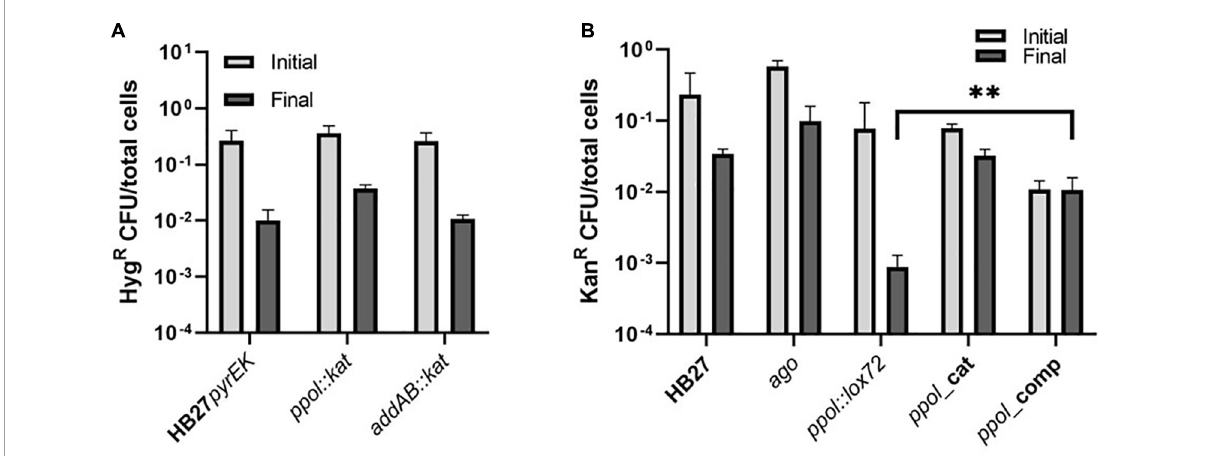
FIGURE5 Plasmid stability in the Thermus. thermophilus mutants. (A) Comparison of plasmid loss frequencies using a replicative plasmid conferring Hyg resistance (pMotH1103A) in HB27 pyrEK control strain and in ppol:kat and addAB:kat insertion mutant strains. Transformed cells were re-streaked twice on selective plates and grown on selective media liquid for 24 h. After that, cells were further incubated for another 48 h in the absence of antibiotic to allow plasmid loss to occur. We finally plated cells on both non-selective and selective plates and the plasmid loss frequency was measured as the CFUs on selective media divided by CFUs on non-selective plates (total cells). (B) Comparison of plasmid loss frequencies using a replicative plasmid conferring Kn resistance (pMotK1103A) in HB27 control strain and its derivatives ppol:lox72, ppol_ cat , ppol_ comp, addAB:lox72 and addAB_ppol mutants. Each data point is an average of 3 independent experiments. Error bars correspond to the standard deviation of the means. Asterisks indicate significant statistical differences (** P -value < 0.0002 when comparing the mean of addAB:lox72 with the mean of addAB_ppol